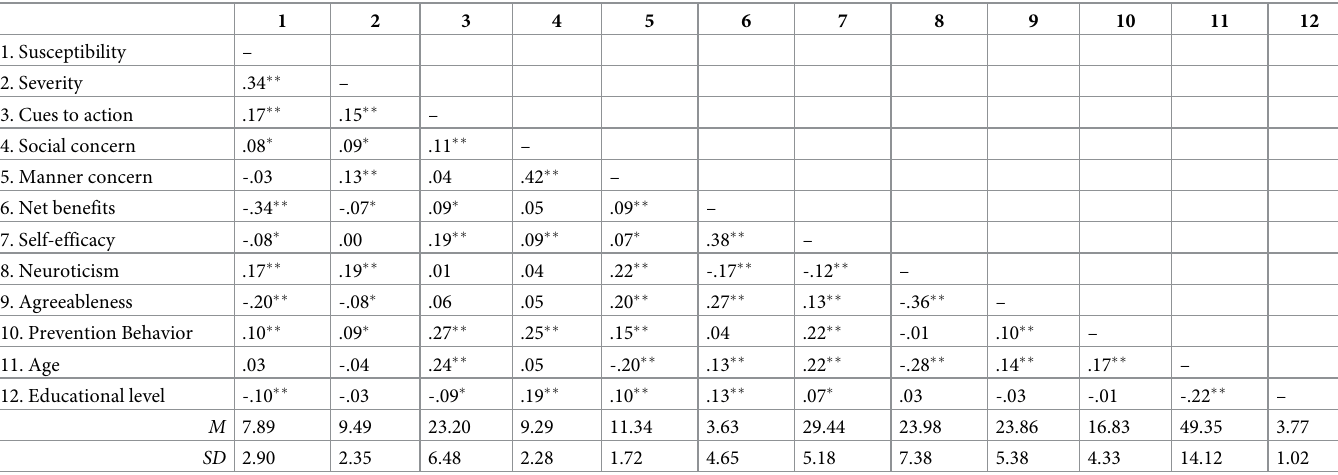
Table 2. Descriptive statistics and correlations of the study variable.